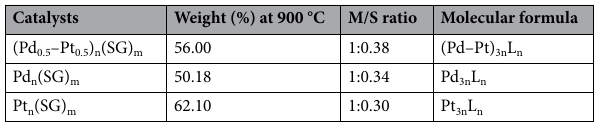
Table 1. The thermogravimetric analysis data for the prepared nanoclusters.